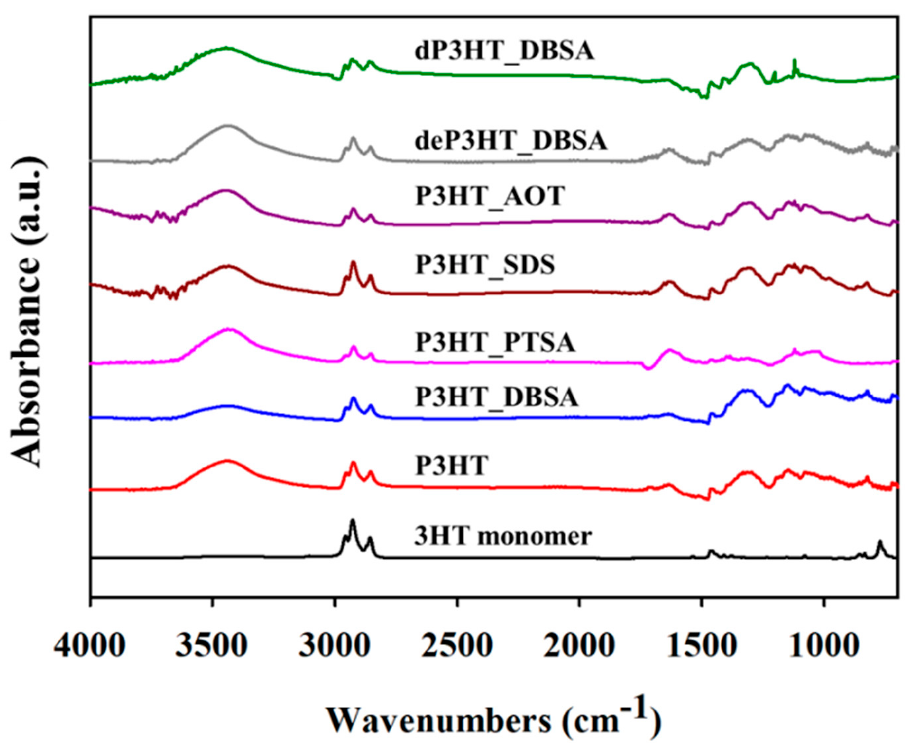
Figure 1. FTIR spectra of P3HT synthesized under different conditions: without surfactant; with various surfactants; before and after the doping process.